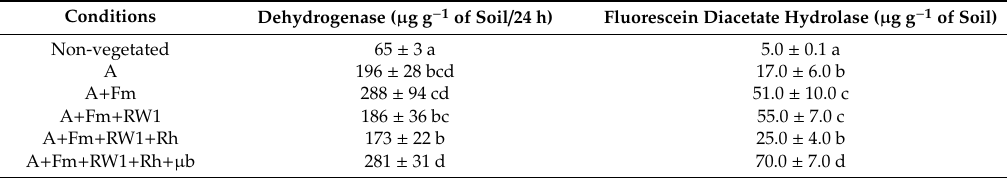
Table 5. DehydrogenaseandFluoresceindiacetatehydrolaseactivitiesinpollutedsoilofdifferentconditions. Conditions consisted of non-inoculated alfalfa (A), alfalfa combined with F. mosseae (A + Fm), plus S. wittichii RW1 (A + Fm + RW1), plus rhamnolipids Rh (A + Fm + RW1 + Rh), plus microbiota µ b (A + Fm + RW1 + Rh + µ b) grown in microcosms for six months. Different letters indicate significant differences between conditions according to the Kruskal–Wallis test ( p ≤ 0.05). Values are means ± s.d. ( n =